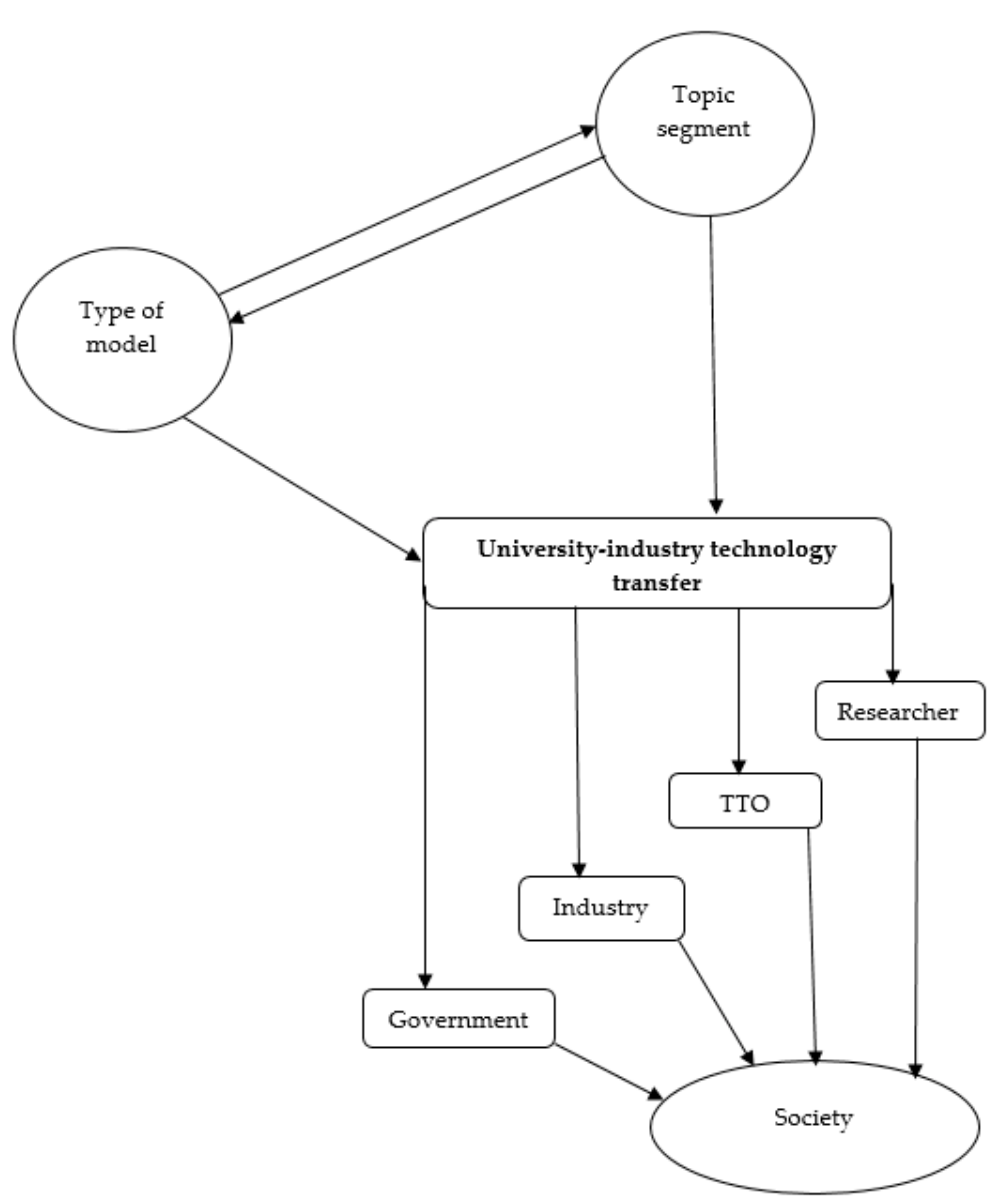
Figure 5. Schematic representation of how models should drive effectiveness of TT.